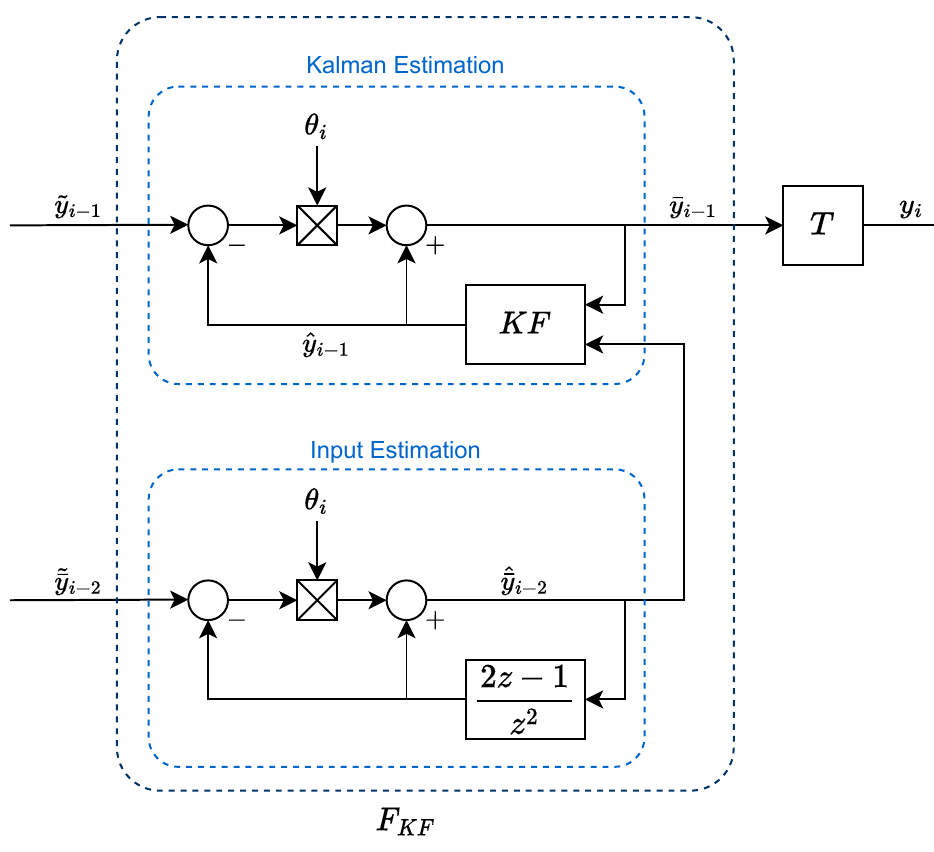
Figure 11. Proposed compensation strategy based on the intermittent Kalman filter. The bottom part performs a linear extrapolation of the transmitted preceding vehicle’s input signal ˜¯ y i − 2 , and the top part performs the transmitted preceding vehicle’s output ˜ y i − 1 estimation based on the intermittent Kalman